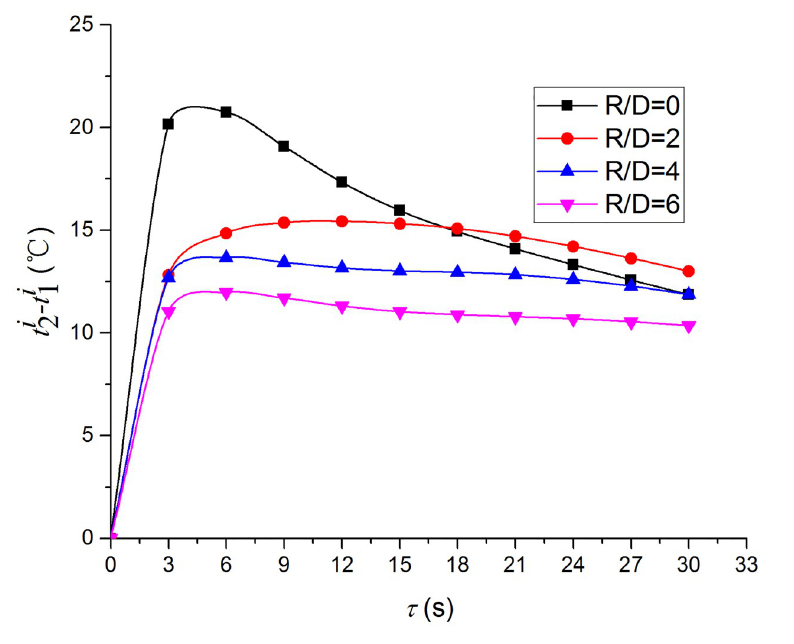
Fig 22. Variations of ð t i